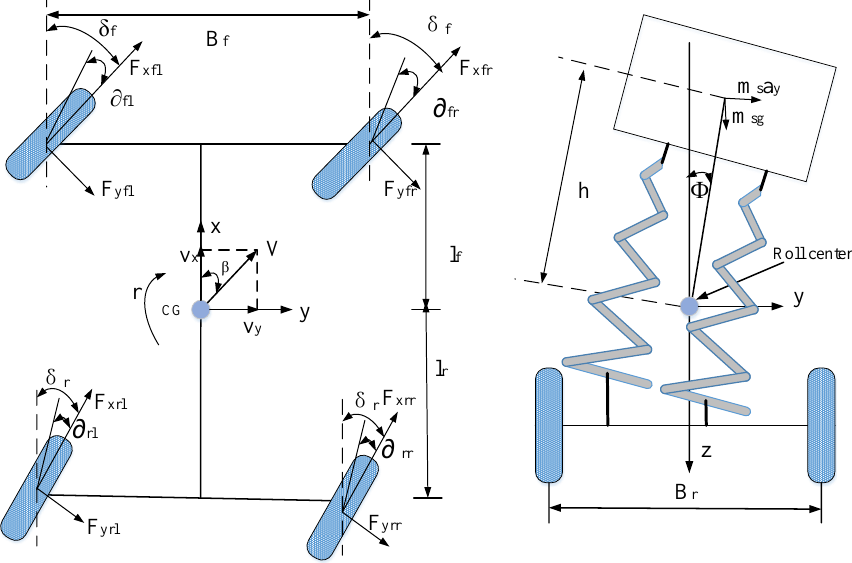
Figure 2. The nonlinear 8DOF vehicle model.